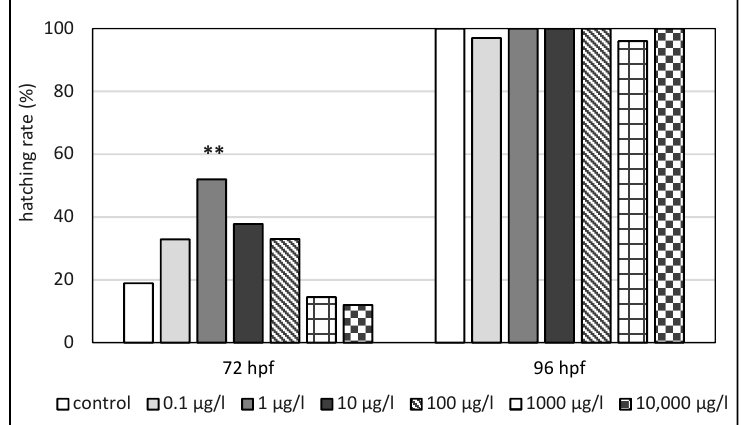
Figure 1. The hatching rate (%) of zebrafish exposed to fluoxetine hydrochloride (hpf—hours post- fertilization). The asterisk indicates a significant difference (** p < 0.01) between the control and the experimental groups at the same time of exposure.